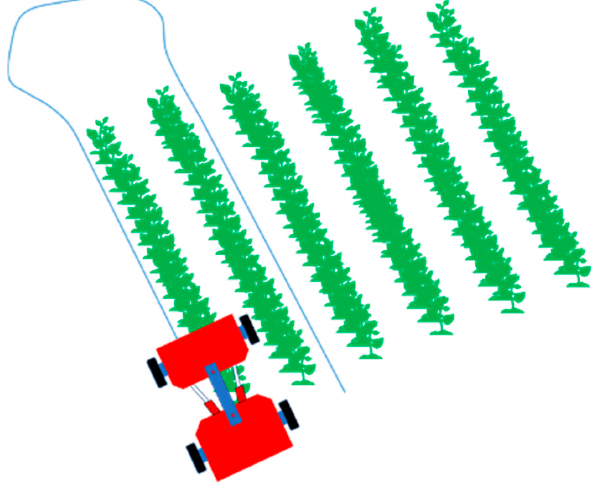
Algorithm 1: Proportional control of the articulation angle.